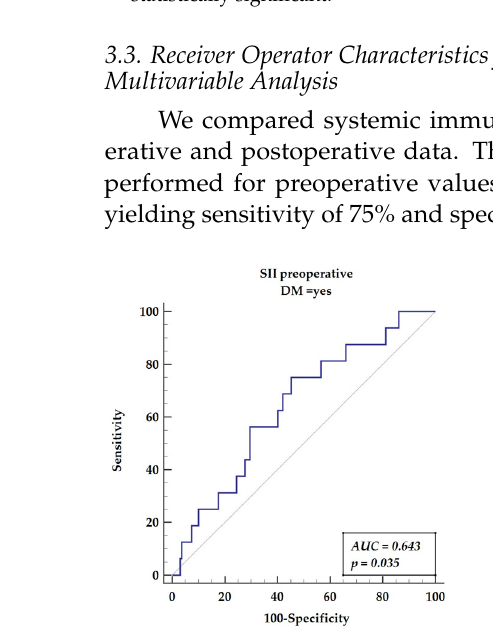
Figure 2. Receiver operating characteristics curve for preoperative SII in DM patients. Abbrevia-